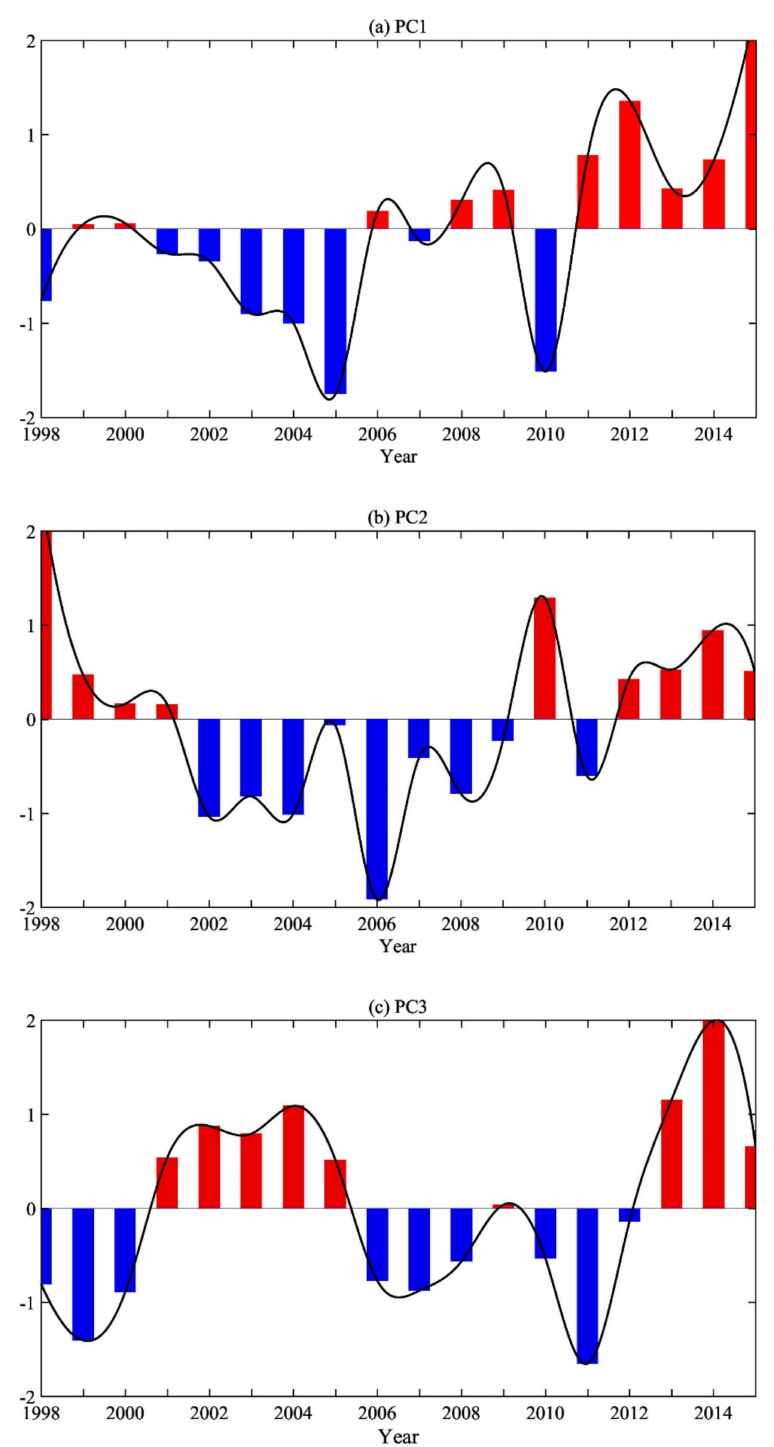
Figure 4. The normalized principal component (PC) of the first three S-EOF modes with interpolated time series (black